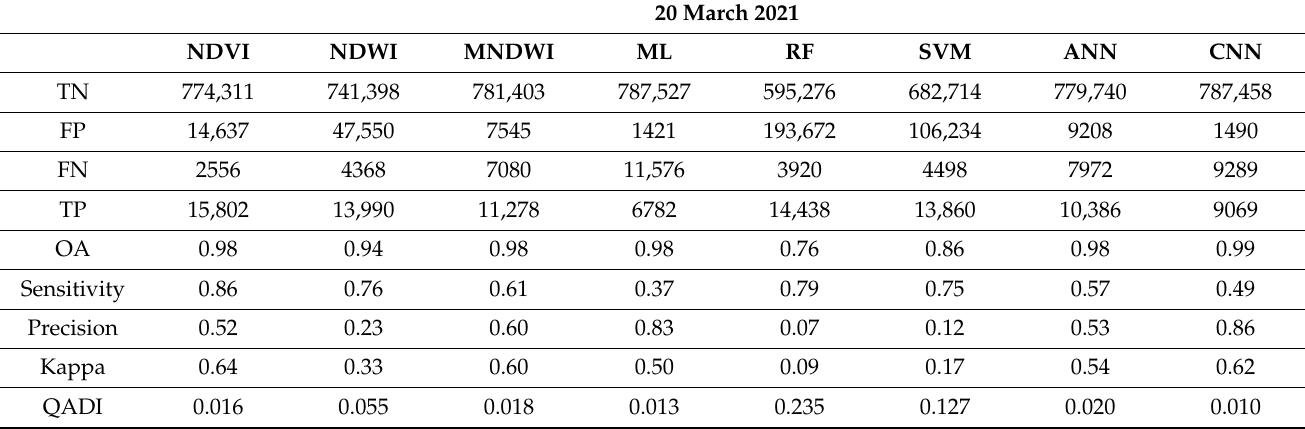
Table 3. Statistical comparison of methods for the third acquisition dates.